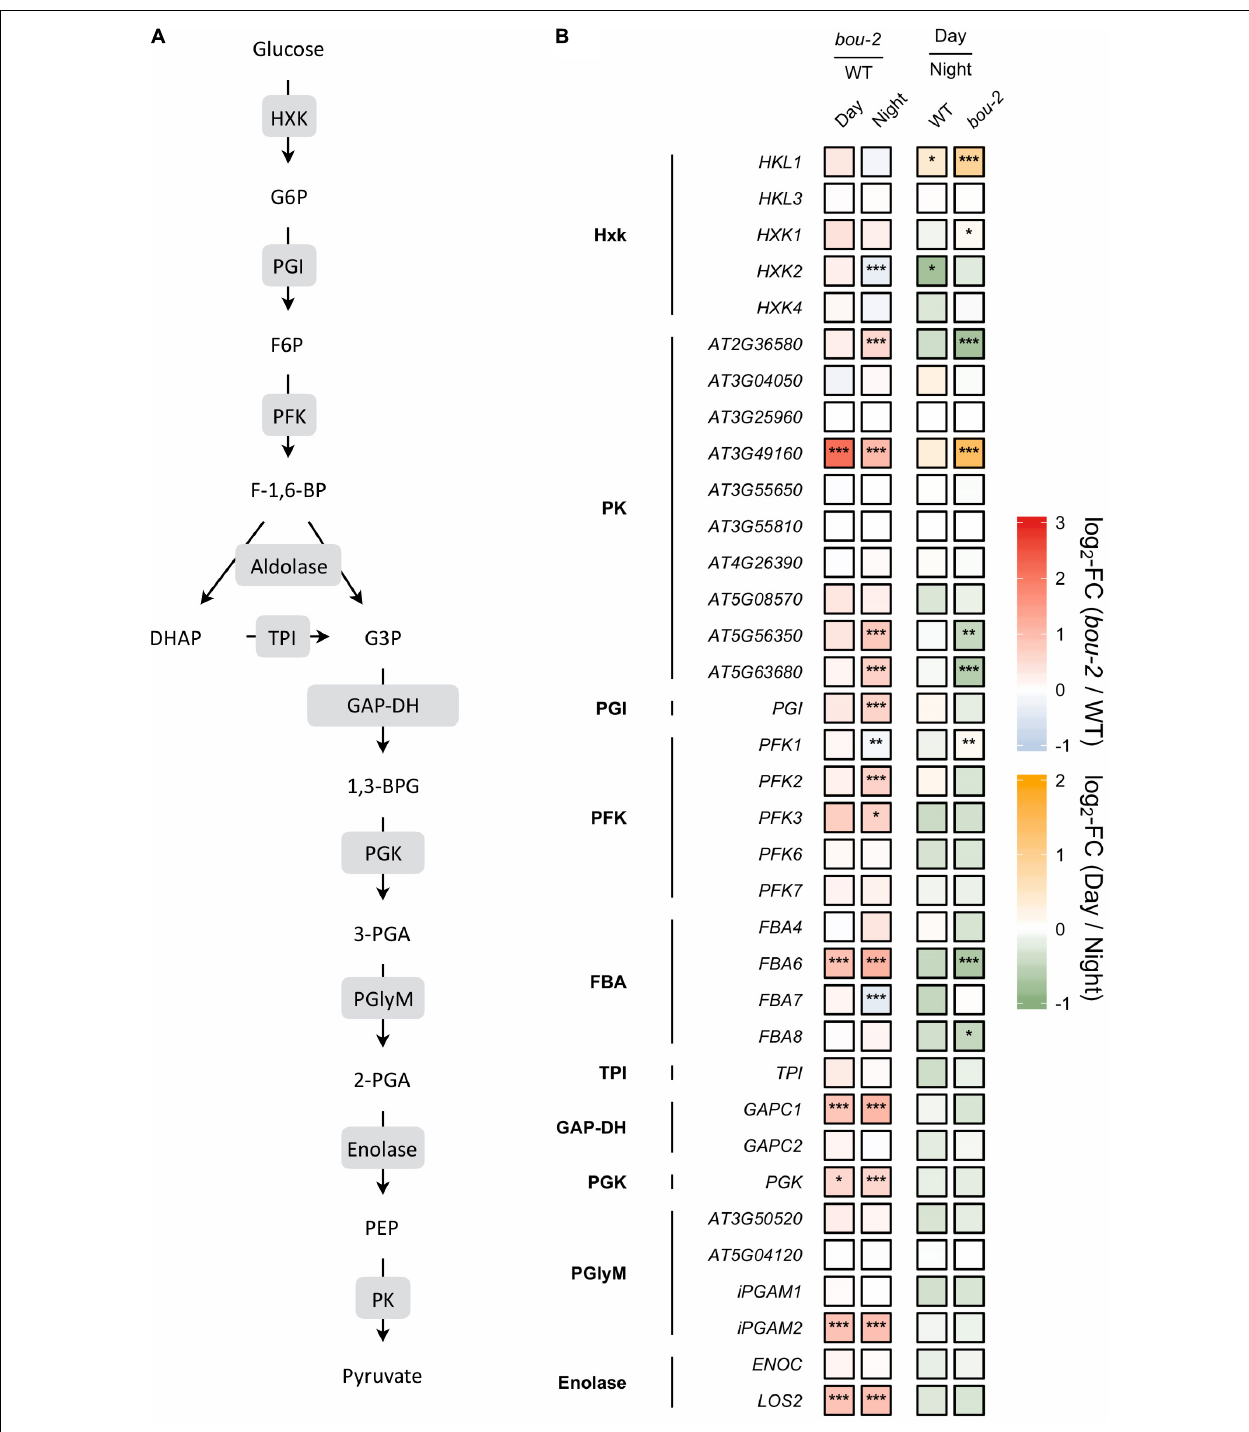
FIGURE 5 | (A) Schematic presentation of glycolysis. (B) Transcript levels of genes encoding for enzymes highlighted in gray boxes in panel A . Left two tiles of each gene represent the log2-fold change (FC) between the bou-2 mutant and WT plants under both day (D) and night (N) with false color code ranging from red (higher in bou-2 ) to blue (higher in WT). Right two tiles represent the log2-fold change (FC) between day and night within WT plants and the bou-2 mutant with false color code ranging from green (higher at night) to yellow (higher at day). Asterisks indicate differential gene expression as determined by Sleuth ( ∗ FDR < 0.05, ∗∗ FDR < 0.01, and ∗∗∗ FDR < 0.001). HXK, hexokinase; PGI, phosphoglucose isomerase; PFK, phosphofructokinase; FBA, fructose-bisphosphate aldolase; TPI, triosephosphate isomerase; GAP-DH, glyceraldehyde-3-phosphate dehydrogenase; PGK, phosphoglycerate kinase; PGlyM, phosphoglycerate/bisphosphoglycerate mutase; PK, Pyruvate